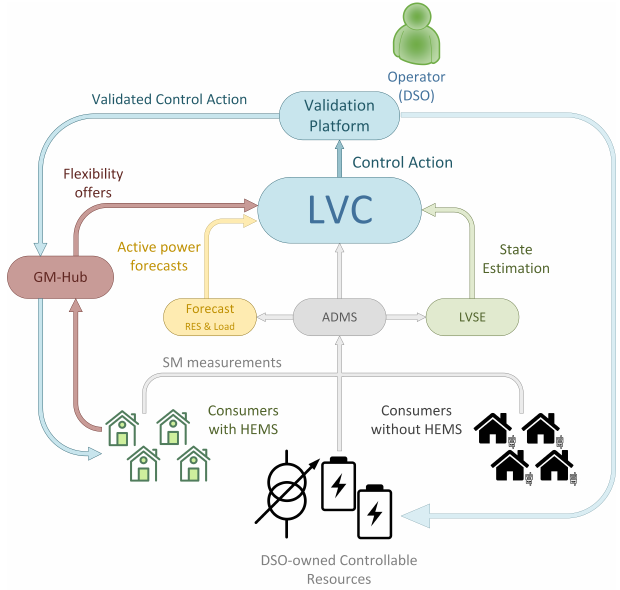
Figure 1. Proposed framework for the Low Voltage Control